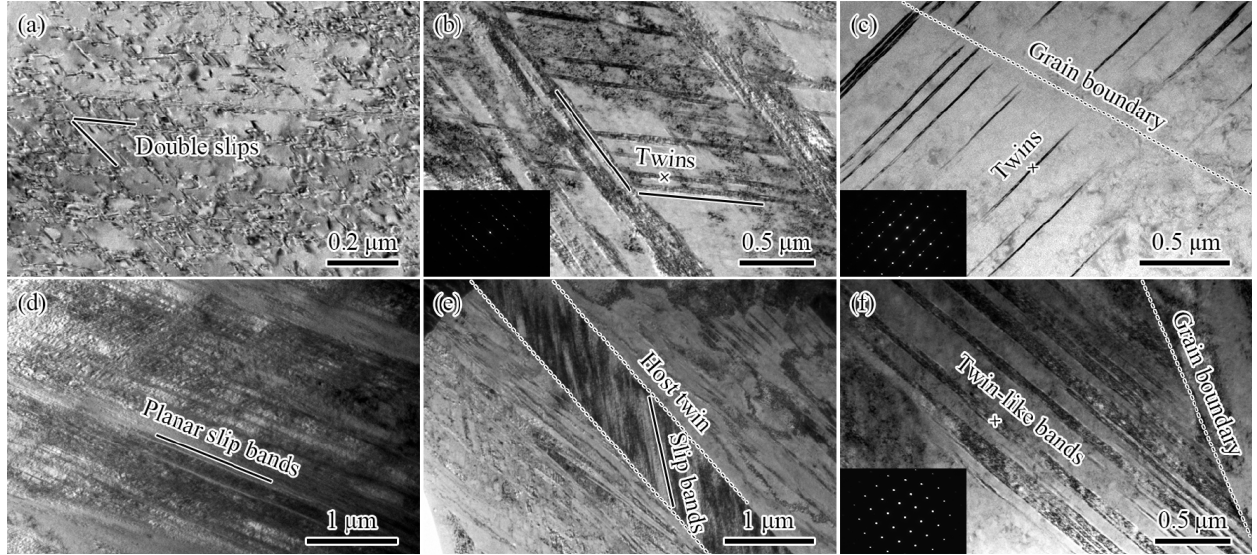
Figure 5. TEM images showing the deformation microstructures in Fe-18Cr-16Mn-2Mo-0.85N steel at the strain rates of 10 − 2 s − 1 ( a – c ) and 10 − 4 s − 1 ( d – f ). Note that the inset in ( b , c , f ) is the SADP.